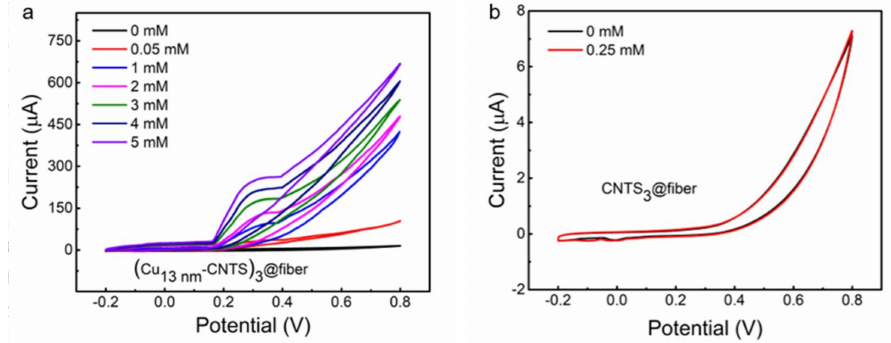
Figure 5. ( a , b ) Cyclic voltammograms of the (Cu 13nm -CNTS) 3 @fiber electrode at different glucose concentrations (0, 0.05, 1, 2, 3, 4, and 5 mM) ( a ) and the CNTS 3 @fiber electrode ( b ) in PBS solution at 0% strain and 100 mV s − 1